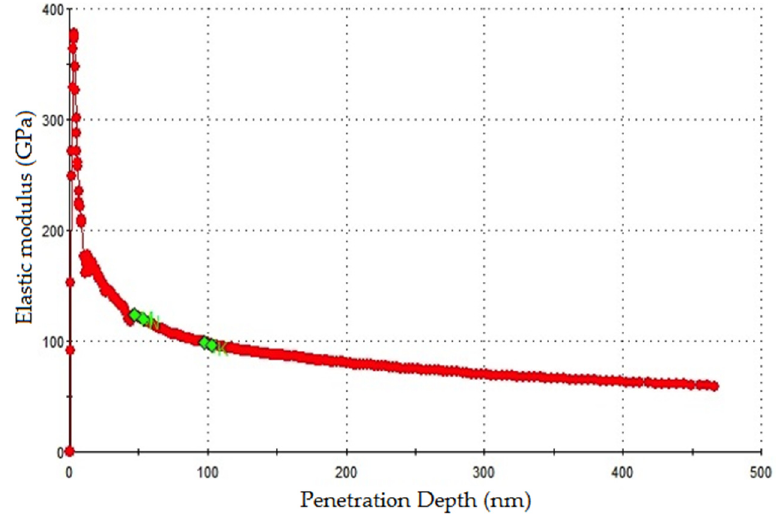
Figure 9. Variation of elastic modulus with the depth of indentation on glass flakes.